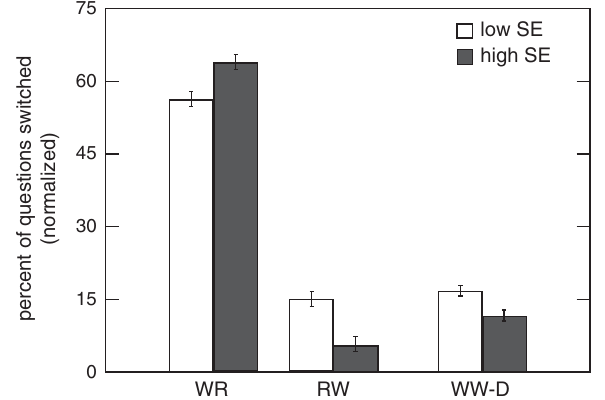
FIG. 3. Average percent of questions switched in each of the three directions (wrong to right, right to wrong, wrong to different wrong) normalized with respect to the first response, for students with high and low self-efficacy